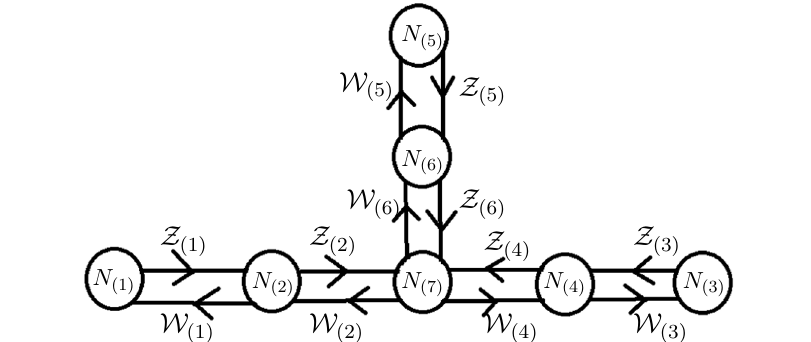
Figure 3 . b E 6 quiver